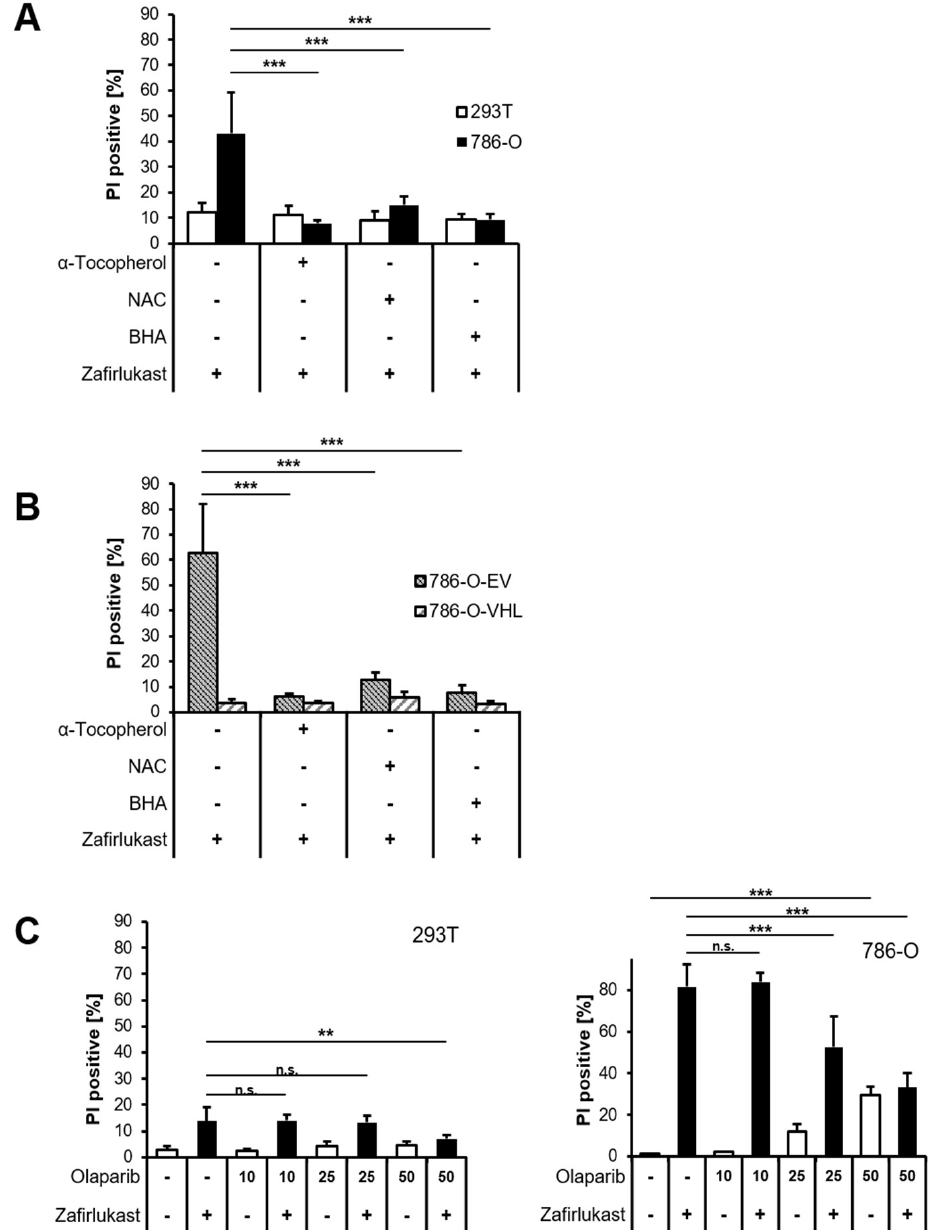
Figure 4. Zafirlukast elicits oxidative PARP-1-dependent cell death. ( A ) 786-O and 293T cells were pre-treated with α -Toc (100 µ M), NAC (10 mM), and BHA (50 µ M), followed by treatment with DMSO or 100 µ M zafirlukast for 24 h, after which cell death was determined by quantifying PI uptake. Data are presented as percentage of PI-positive cells and mean and SD of four independent experiments performed in triplicate are shown. *** p < 0.001; ( B ) Idem as ( A ) but with 786-O-EV and 786-O-VHL cells; ( C ) 293T ( left ) and 786-O ( right ) cells were pre-treated with the indicated concentrations of the PARP-1 inhibitor Olaparib for 1 h, followed by treatment with DMSO or 100 µ M zafirlukast for 24 h, after which cell death was determined by quantifying PI uptake. Data are presented as percentage of PI-positive cells and mean and SD of three independent experiments performed in triplicate are shown. ** p < 0.01, *** p < 0.001, n.s.: non-significant.